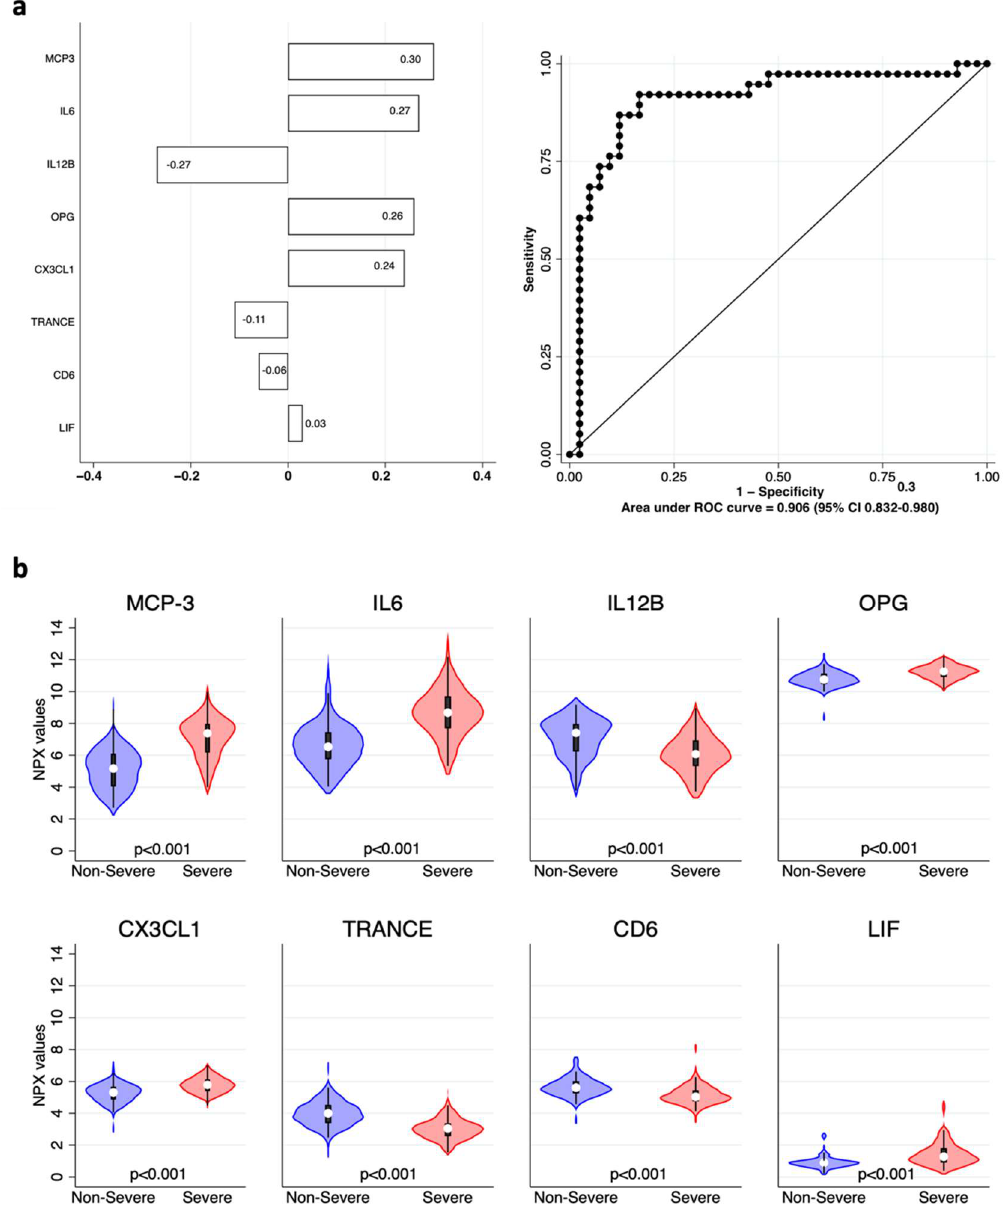
Figure 3. Inflammatory biomarkers associated with COVID-19 severity. ( a ) Elastic net logistic regression with inflammatory variables. Coefficients of each variable are shown in the left panel as horizontal bars. The right panel shows the ROC and AUC of 0.906 (95% CI 0.832–0.980). ( b ) Violin plots showing the distribution of the normalized protein expression (NPX) values of each variable included in the model in “non-severe” (blue) vs. “severe” (red) patients; p values for each comparison are shown at the bottom of each plot.